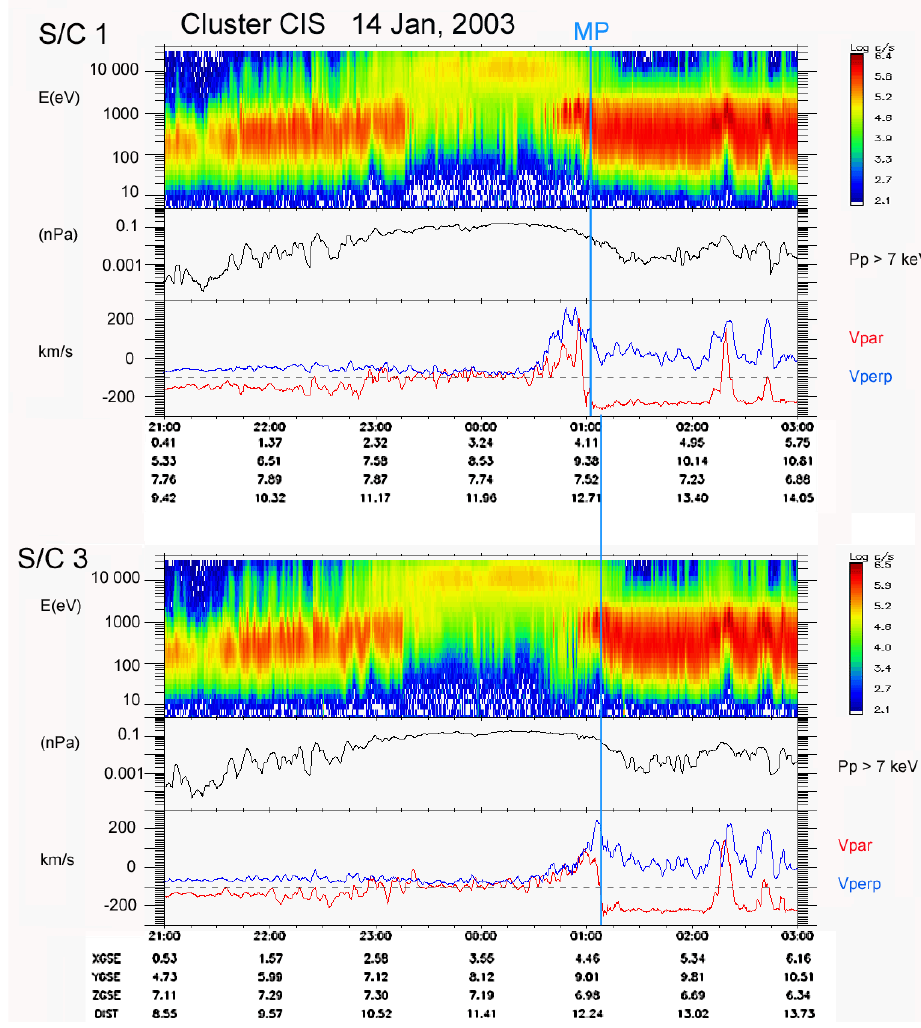
Fig. 2. Overview plot of Cluster s/c 1 and s/c 2 CIS-data on 14 January 2003. The panels illustrate, from top to bottom: energy-time ion spectrograms, ion pressure for energies greater than 10keV, and parallel (red) and perpendicular (blue) ion flow velocities, respectively. The blue line marked “MP1” marks the magnetopause traversal of s/c 1. Left blue line marks the exit of the